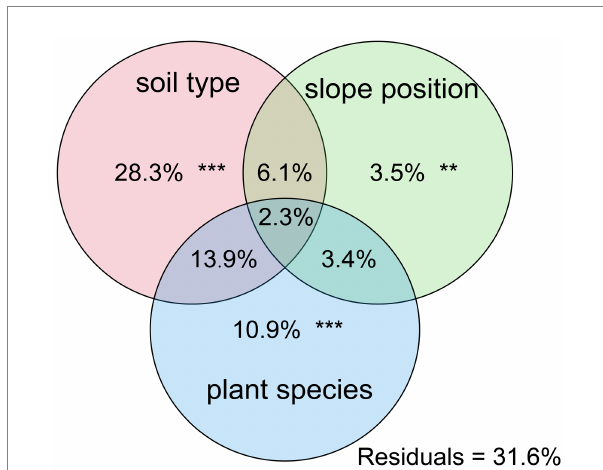
FIGURE 4 Contributions of soil type, slope position, and plant species on the assembly of soil bacterial communities were calculated based on variance partitioning analyses (VPAss), and p -value was determined by